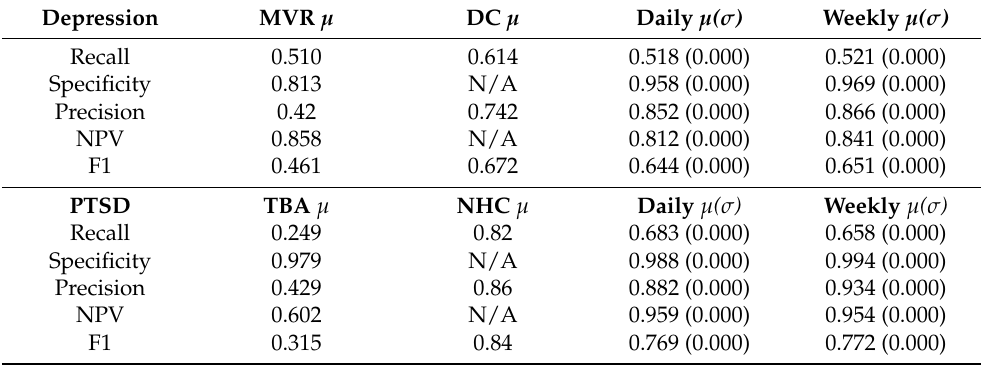
Table 1. Comparison results as shown by Reece et al. [56]. Cells marked N/A indicate unavailable metrics from previous